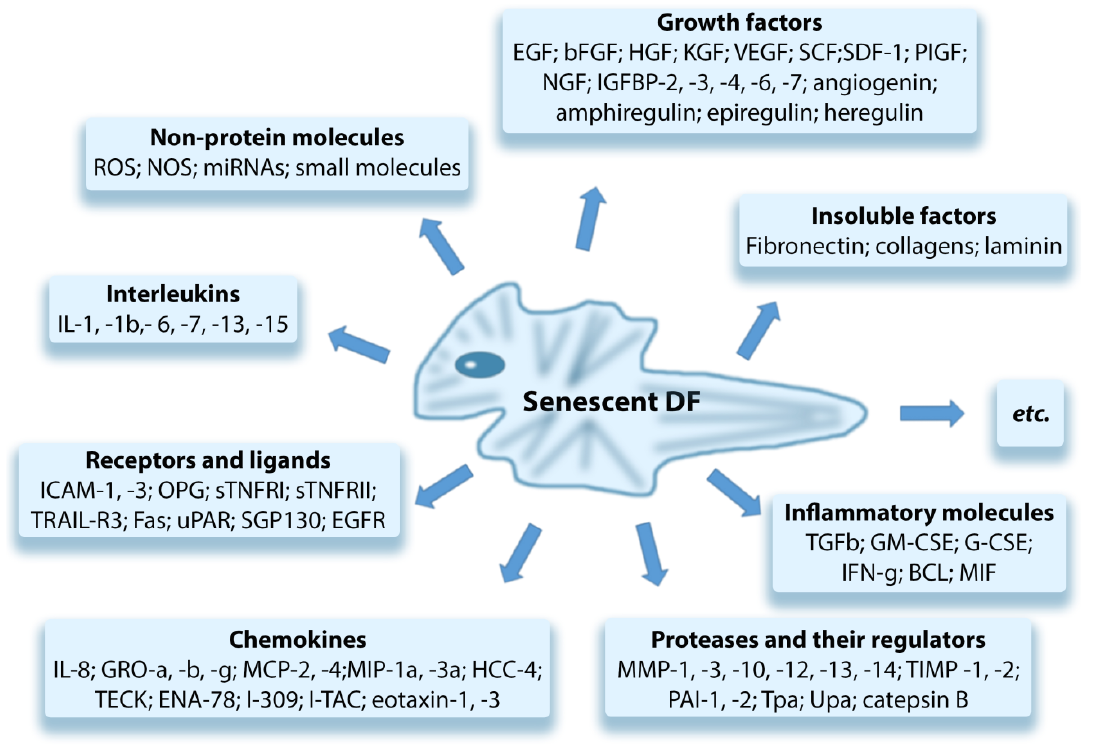
Figure 4. Components of the senescence-associated secretory phenotype (SASP).